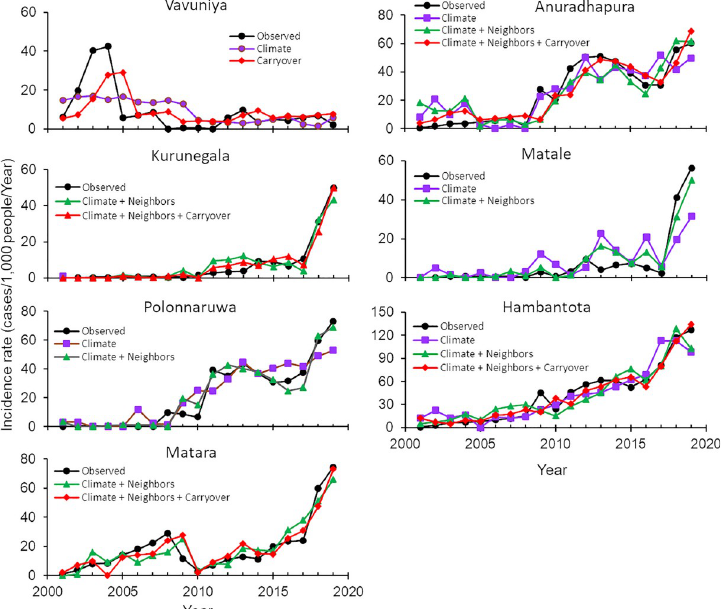
Fig 5. Observed and model-predicted temporal changes in incidence rate in the seven districts with the highest case numbers. Climate, neighbor, and carryover represent climatic, neighboring-district dispersal, and carryover effects, respectively. The results of goodness-of-fit of each model were presented in Table 1, predictions was only made with significantly fitted models.